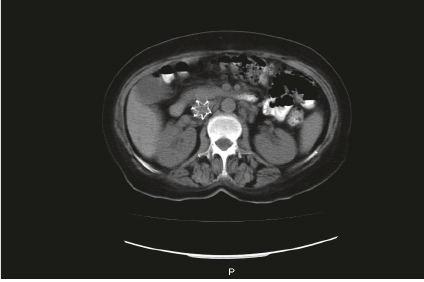
Figure 2: Vena cava filter.